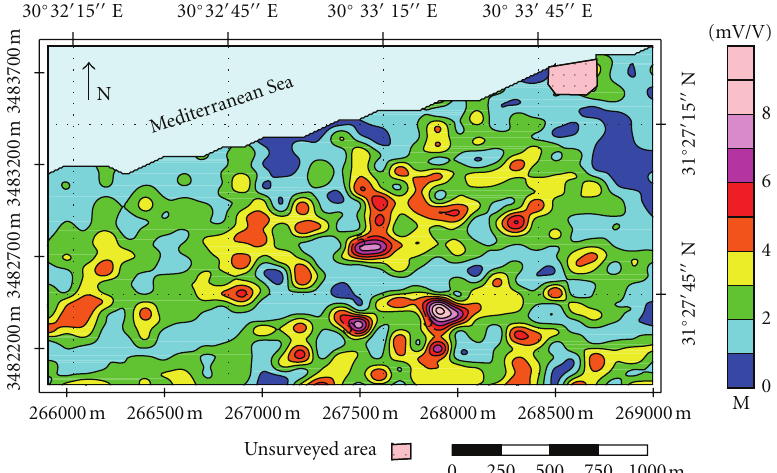
Figure 13: Filled colour contour map of the electric chargeability ( M ) laboratory measurements, Koam Mashaal area, East Rosetta, Mediterranean Sea Coast, Northern Egypt. Logarithmic contour interval = 1